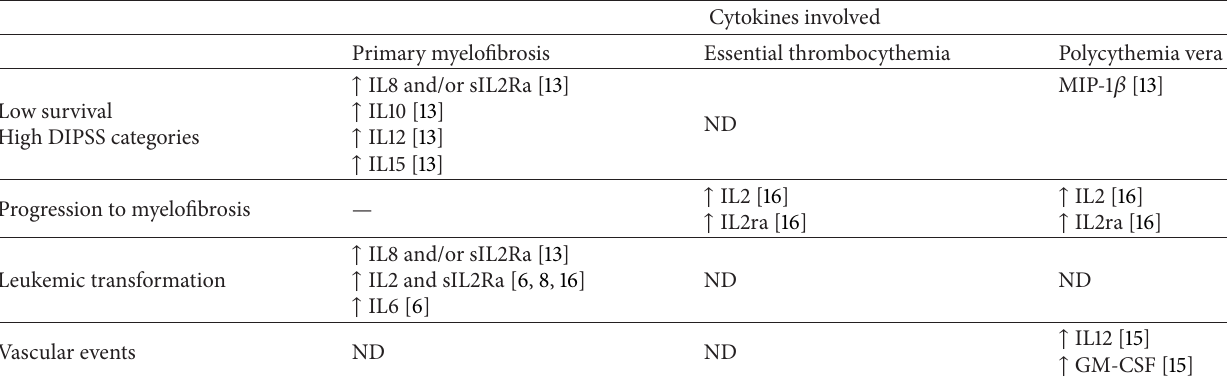
Table 2: Cytokines with prognostic